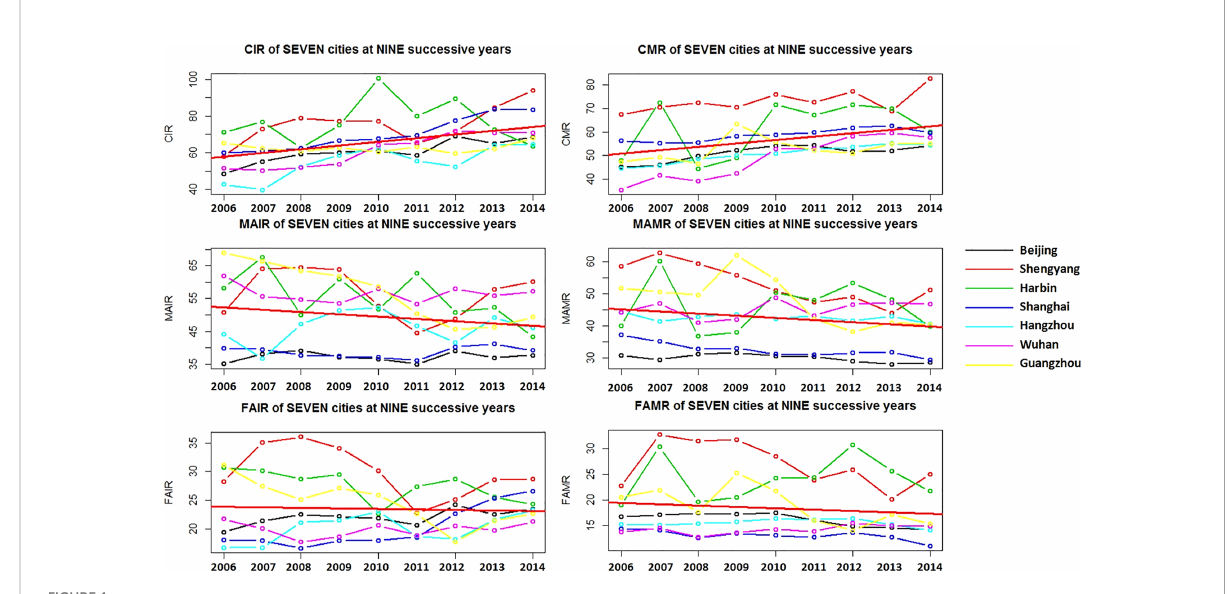
FIGURE 1 Year trends of lung cancer incidence and mortality in the seven selected cities. The Y-axis (%) was fi tted with data range. The red bold line represented the estimated year trend based on integrated regression of seven cities.